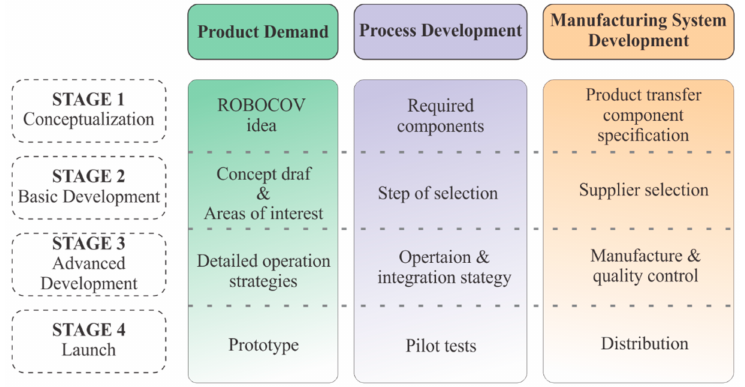
Figure 1. Design and manufacturing